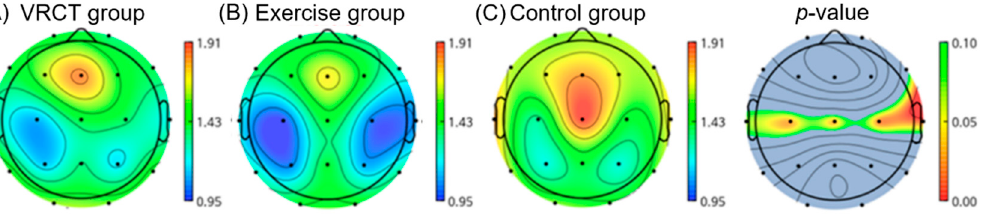
Figure 3. This is a figure shows difference in theta/beta power ratio (TBR) in the central area (parietal